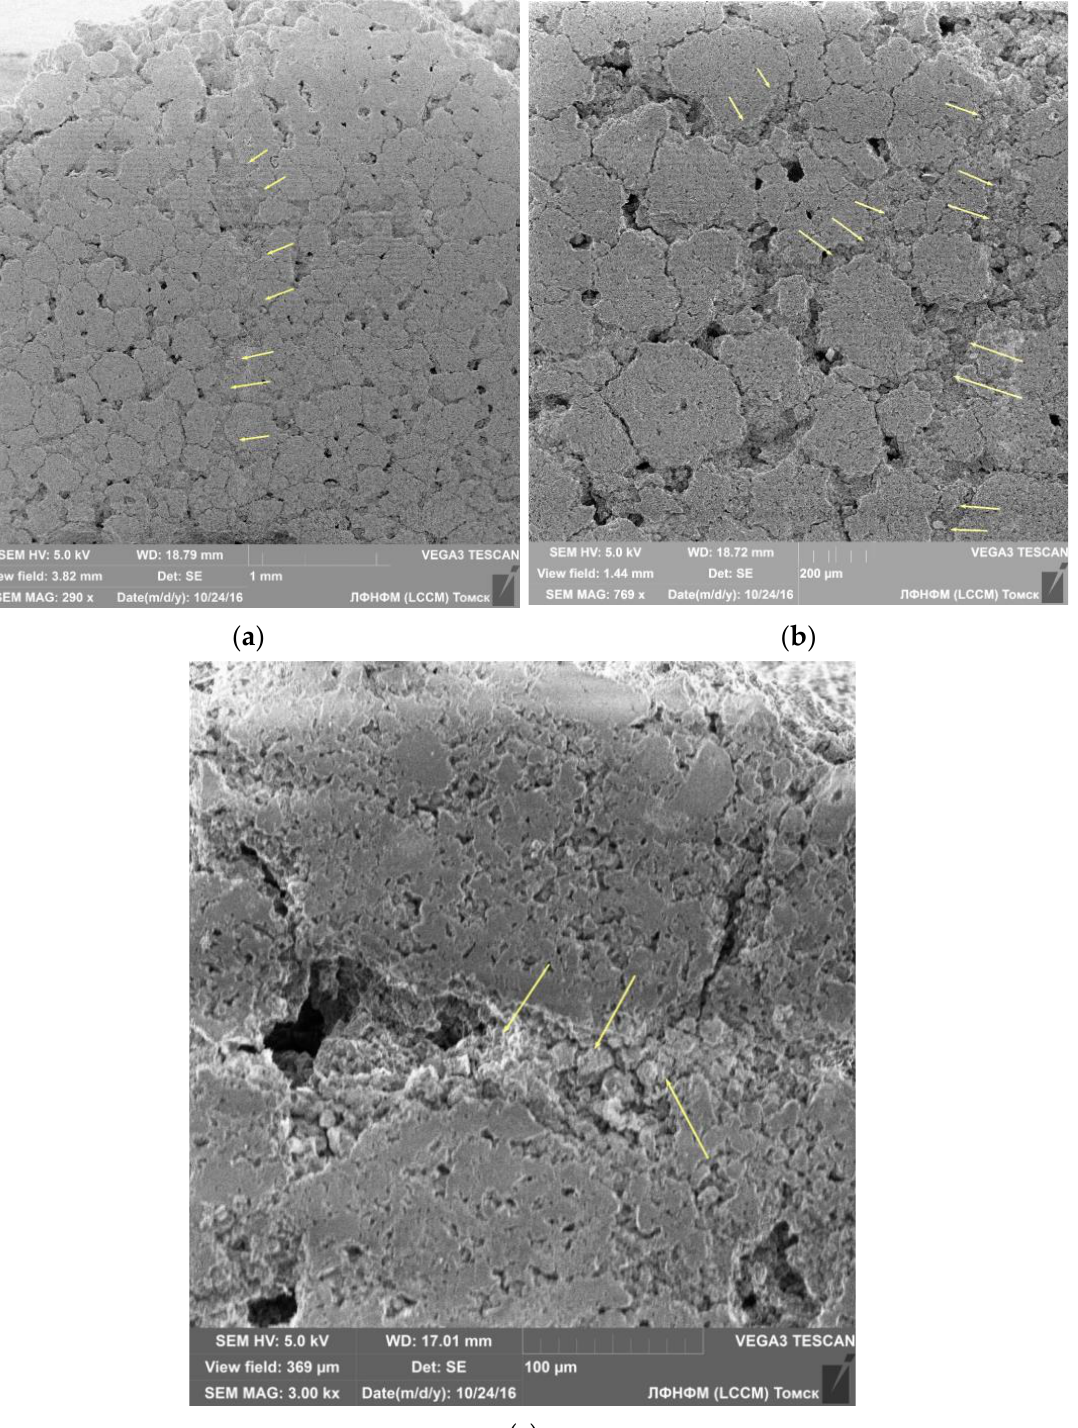
Figure 21. Ex situ SEM BSE images of compaction macrobands ( a ) and accommodative compaction bands ( b , c ) . Sample #1 data are shown.